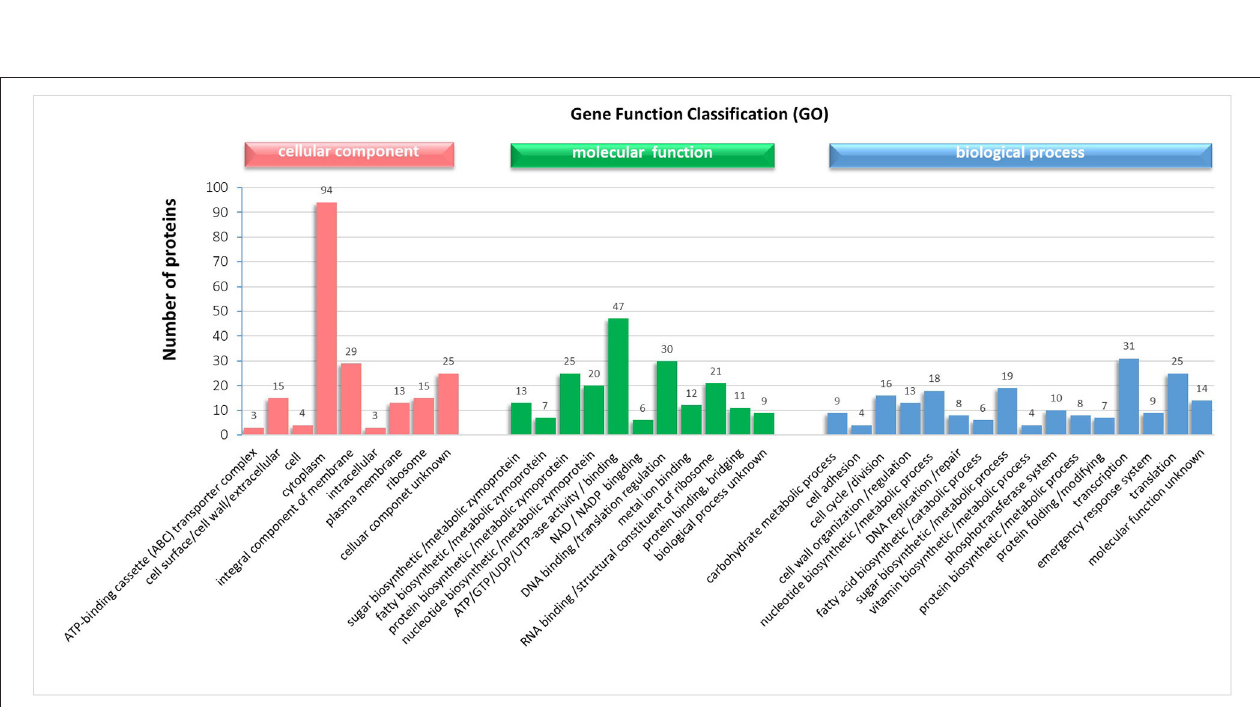
FIGURE 6 | Gene ontology (GO) analysis of the proteins in the mixture proteins obtained from the surface of L. plantarum HC-2 with LiCl-treated and identified by LC-MS/MS performance.